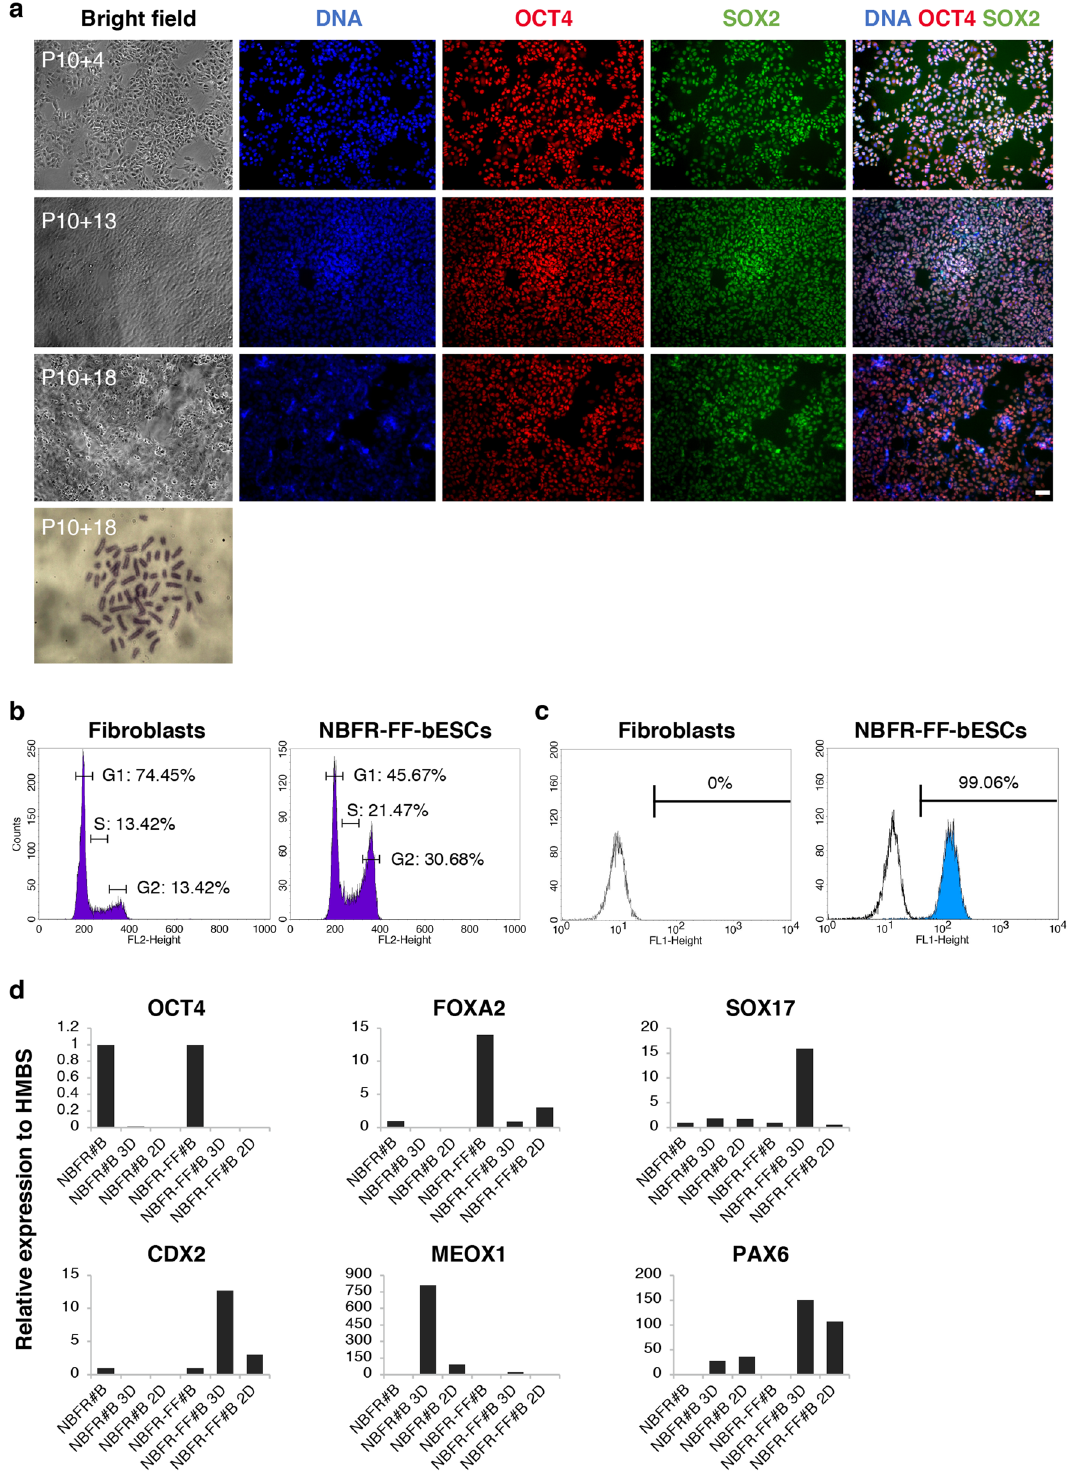
Figure 4. Characteristics of NBFR-bESCs grown under feeder-free conditions. ( a ) Immunostaining of OCT4 and SOX2, and normal chromosome number (2n = 60) of NBFR-bESCs grown for multiple passages on vitronectin supplemented with Activin A ( b ) Flow cytometry analysis of bovine fibroblasts and NBFR-bESCs cultured in feeder-free conditions (NBFR-FF-bESCs) indicating the DNA content and the percentage of cells in each phase of the cell cycle. ( c ) Quantification of OCT4 expression in NBFR-FF-bESCs (blue peak) and secondary only control (unshaded peak). ( d ) Expression levels of genes ( OCT4 , FOXA2, SOX17, CDX2, MEOX1, PAX6 ) representative of different lineages after 3D (3 weeks) and 2D (4 weeks) in vitro differentiation in NBFR-bESCs lines before (NBFR#B at passage 10) and after adaptation to feeder-free culture (NBFR-FF#B at passage 11). Relative expression was calculated using the comparative CT method (ΔΔCT), normalizing values to HMBS . P: passage. Scale bar 100